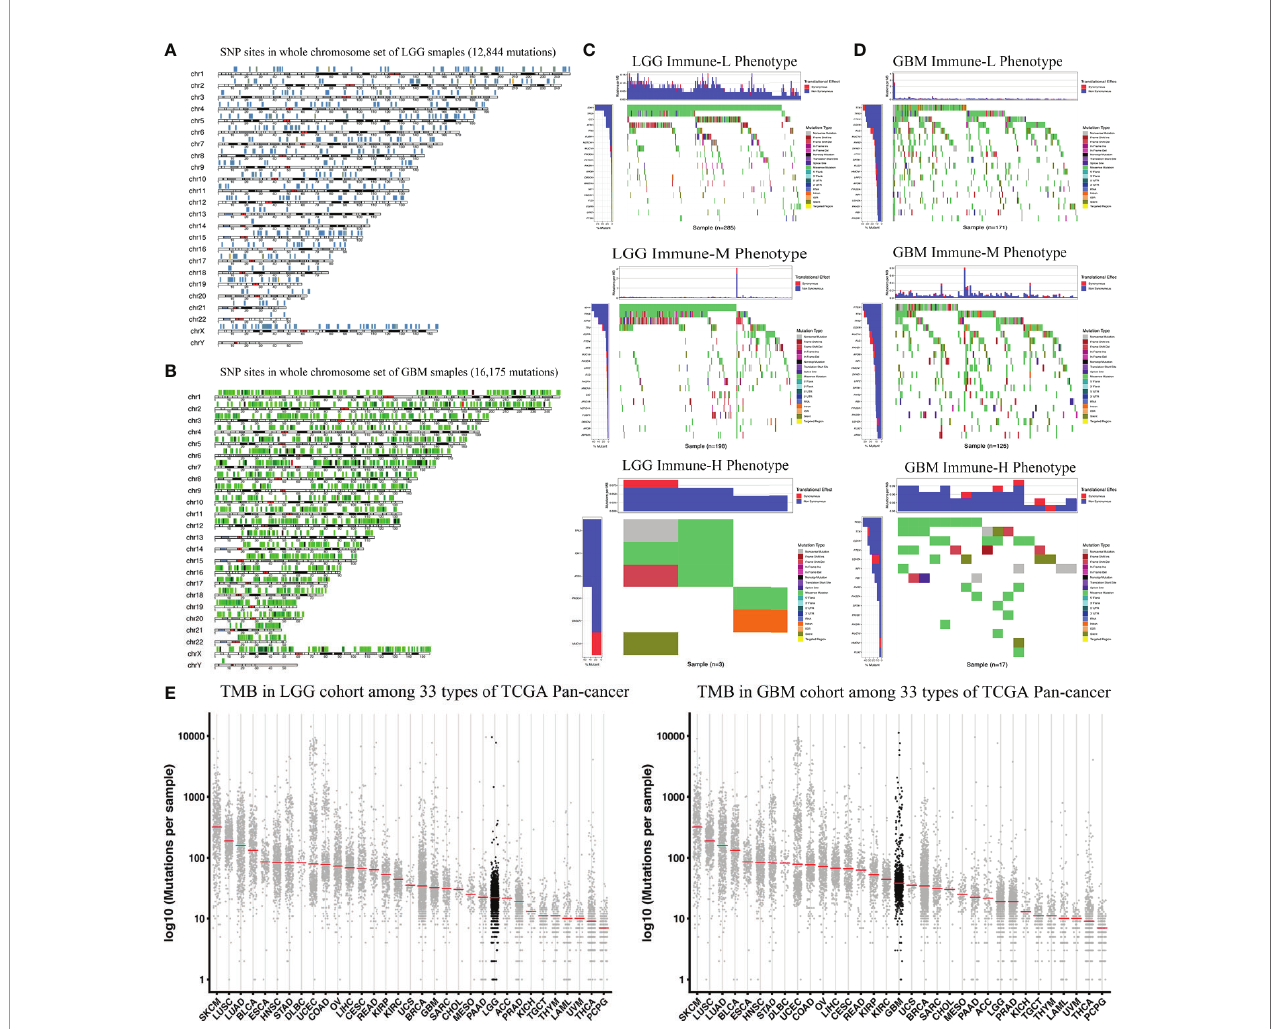
FIGURE 9 | Waterfall plots of genomic alternations associated with glioma immune phenotypes. (A, B) Recurrent SNP sites of LGG and GBM in chromosome models. Red and orange marked high-mutant SNP, navy and green marked low-mutant SNP. (C) The waterfall plots summarize the genomic alternations including somatic mutations and single nucleotide polymorphism in LGG of immune-L, immune-M and immune-H phenotypes respectively. (D) The waterfall plots summarize the genomic alternations in GBM of immune-L, immune-M and immune-H phenotypes respectively. (E) Scatter plots show tumor mutation burden of LGG and GBM among 33 types of Pan-cancer respectively. LGG, low grade glioma; GBM,